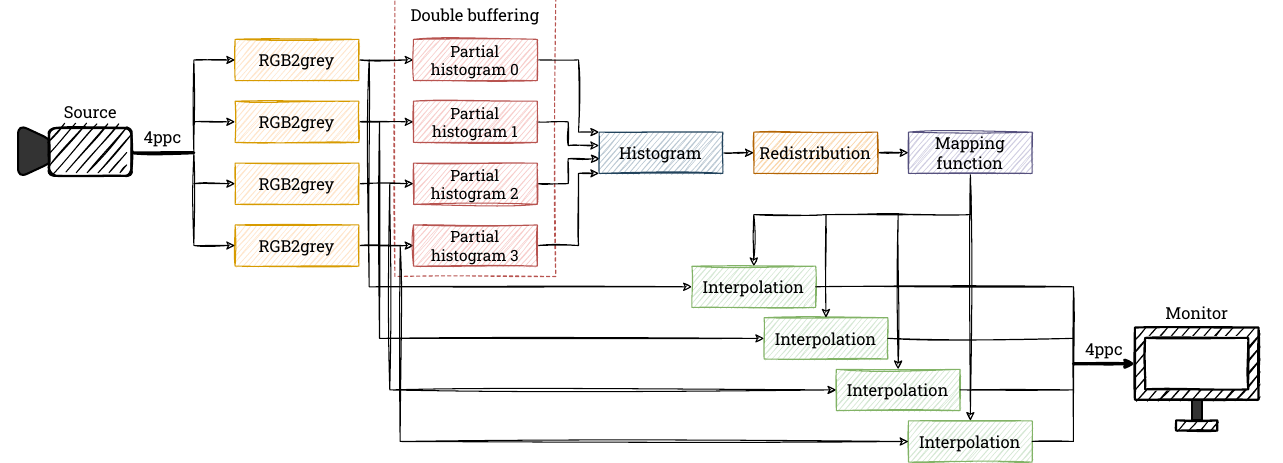
Figure 10. Block diagram of the implemented CLAHE algorithm in the 4 ppc mode. For a stream in the 4 ppc format, a conversion to greyscale (RGB2grey) is performed 4 times simultaneously and 4 partial histograms with 4 partial excesses (omitted from the diagram for clarity) are calculated. The histograms are then integrated, a redistribution is performed, and a mapping function is determined— these steps do not require working with a vector format. The final step—interpolation—is again performed on the 4 ppc